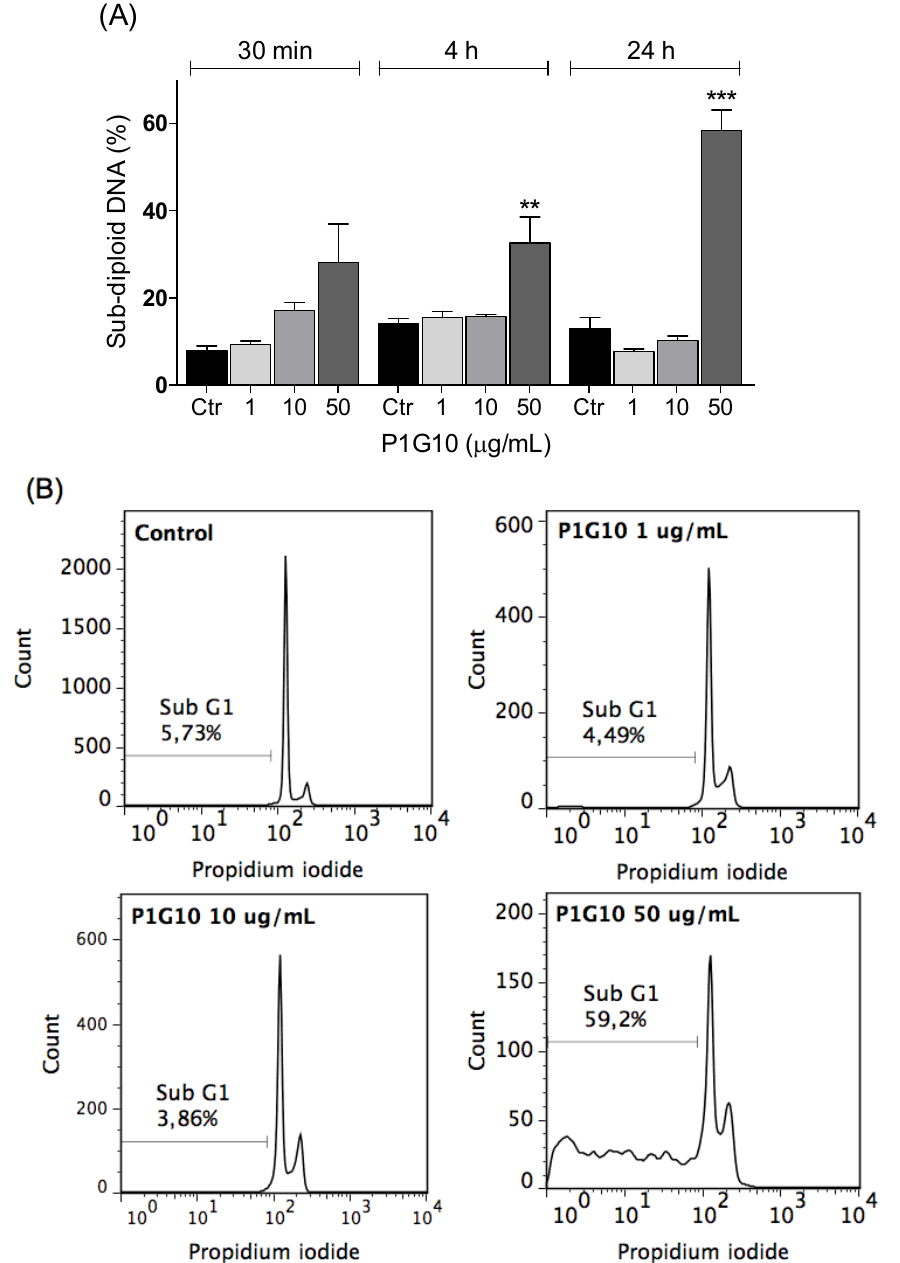
Figure 4. Cell Death. ( A ) B16F1 cells were treated with P1G10 (1, 10 or 50 µg/mL) for 30 min, 4 or 24 h. At the end of treatment, cells were resuspended in hypotonic fluorochrome solution containing propidium iodide. After 2–4 h at 4 °C in the dark, the fluorescence of individual nuclei was measured using a FACS flow cytometer and DNA fragmentation was analyzed by FlowJo Software. Data shown are mean ± SD; and ( B ) Representative histograms are shown of sub-diploid content after P1G10 treatment for 24 h. ** p < 0.01; *** p < 0.001, ANOVA, Bonferroni’s post-test